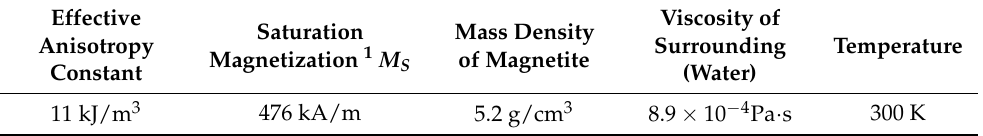
Table 1. Simulation parameters applied in the micromagnetic simulation